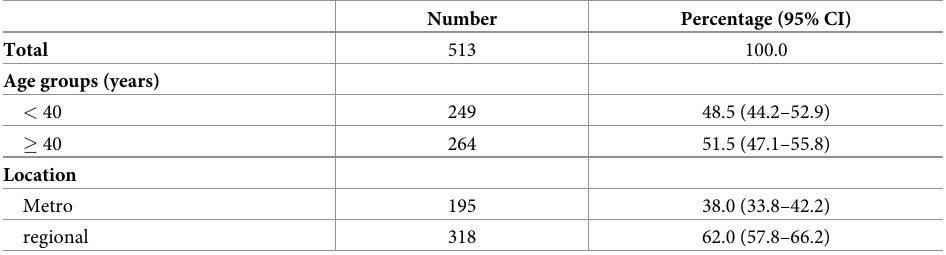
Table 1. Sample characteristics among Indigenous women aged 18+